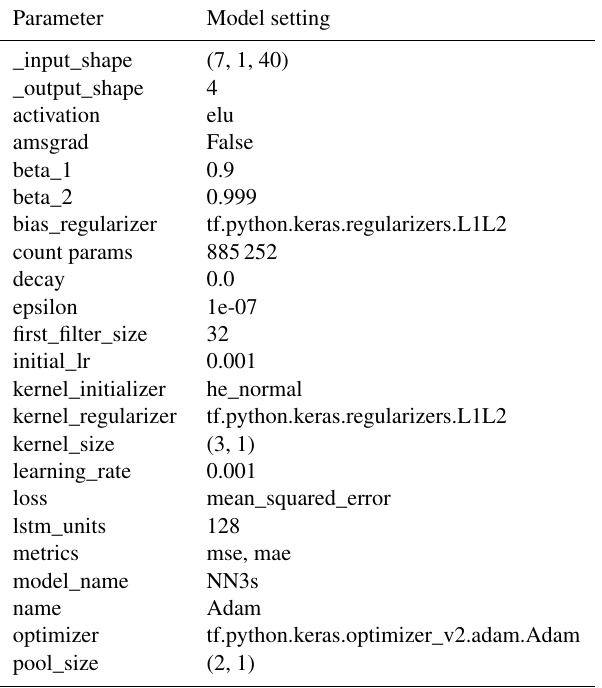
Table A1. Hyperparameters used for NN3s. Parameter Model setting